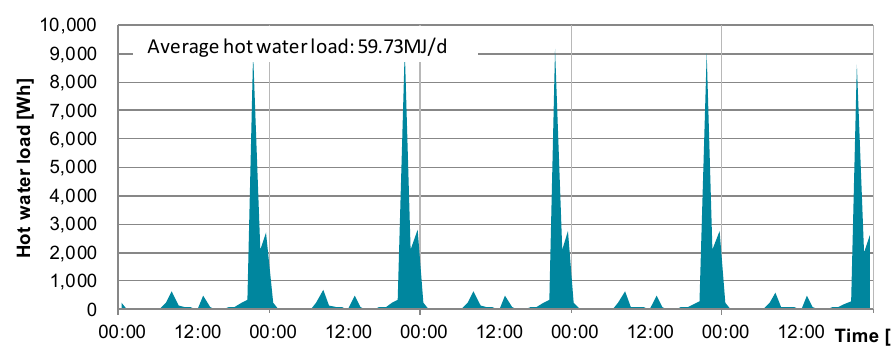
Figure 7. Room temperature results of a typical house. ( a ) First floor; ( b ) Second floor.